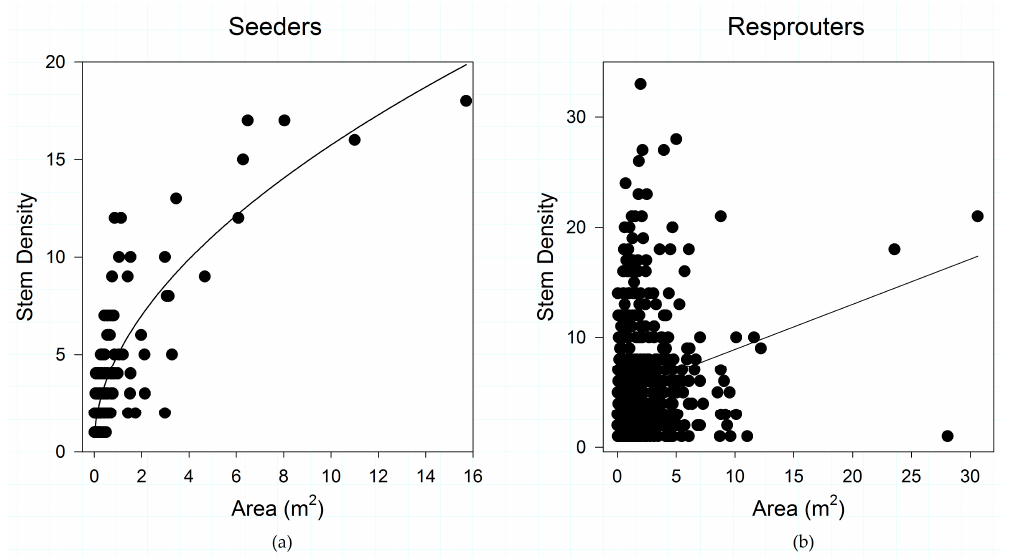
Figure 2. ( a ) Shrub patch structure of obligate post-fire reseeding species; and ( b ) shrub patch structure of obligate post-fire resprouting species, in the study area. Shrub species show a differential response in the relationships between shrub patch area and stem density across regeneration